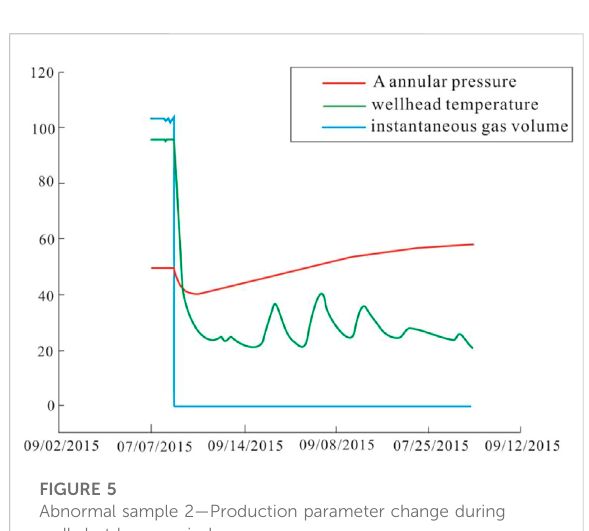
FIGURE 5 Abnormal sample 2 — Production parameter change during well shutdown